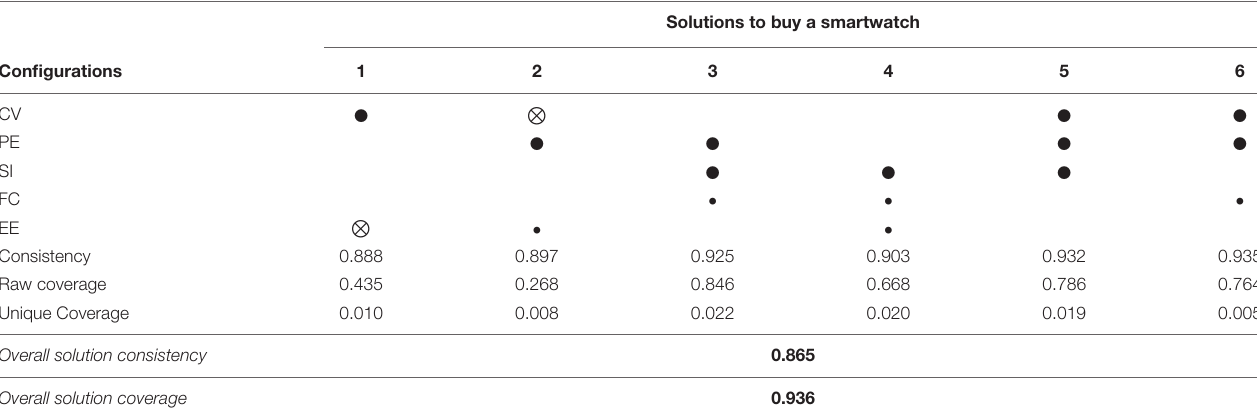
TABLE 6 | Configurations for buying